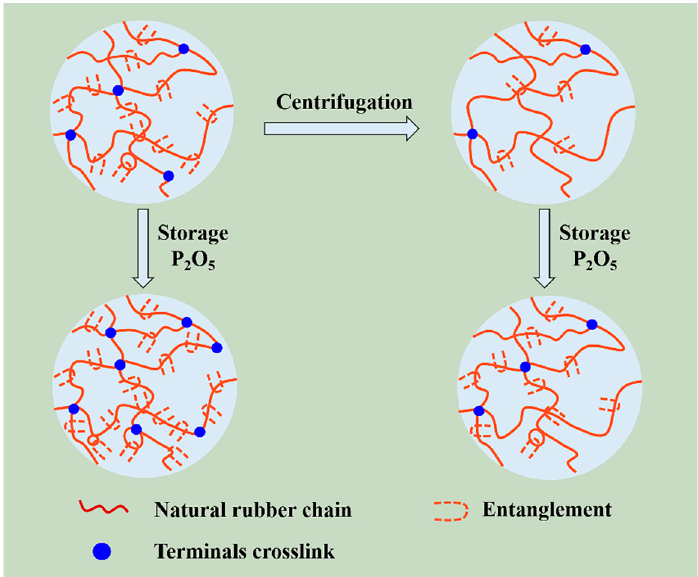
Figure 11. A proposed model for NR after storage hardening.